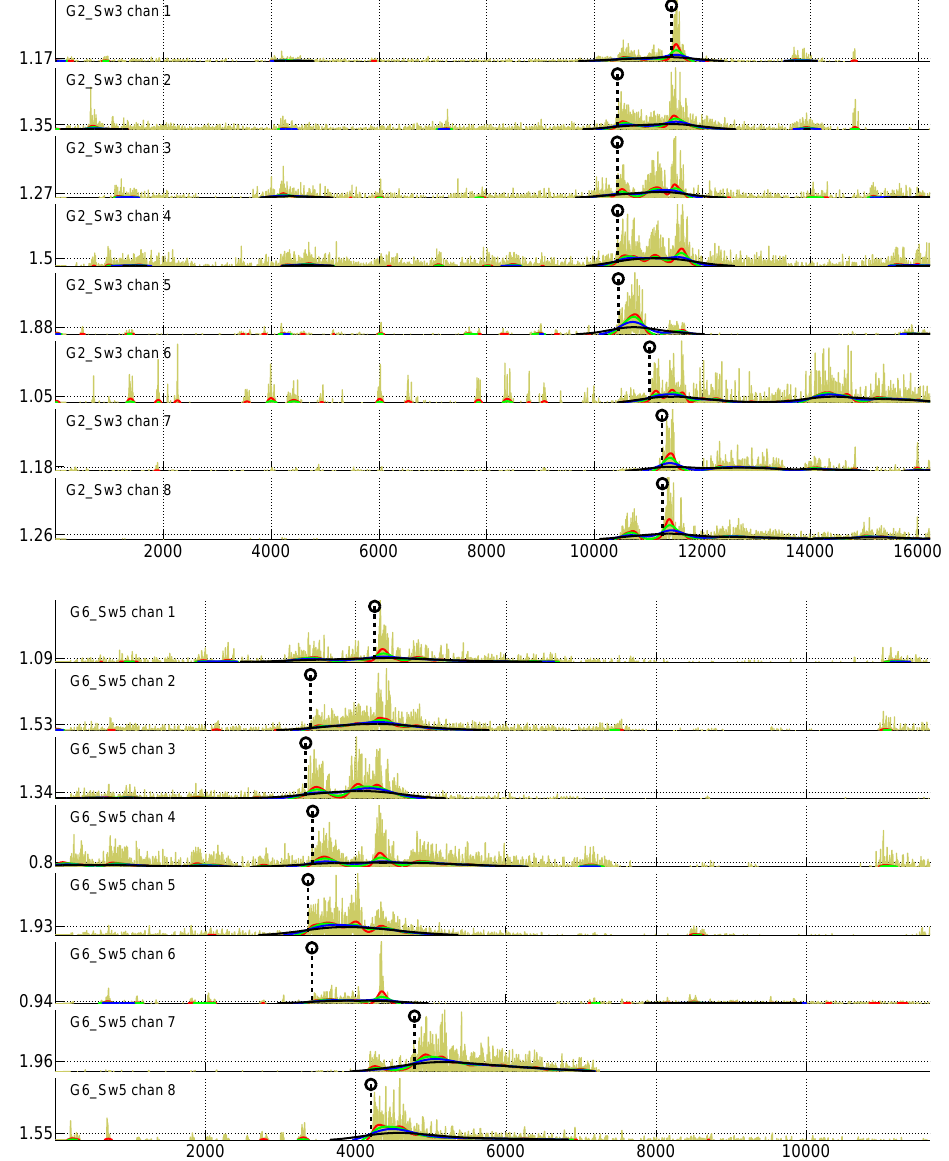
Figure 3. EMG signals recorded from eight muscles of golf players G2 ( Top ) and G6 ( Bottom ). Note: position in samples on the X (horizontal) axis. Channel numbers correspond to the following muscles: (1) right FCR ; (2) right EDC ; (3) left FCR ; (4) left EDC ; (5) right rhomboideus ; (6) right trapezius ; (7) left rhomboideus ; and (8) left trapezius